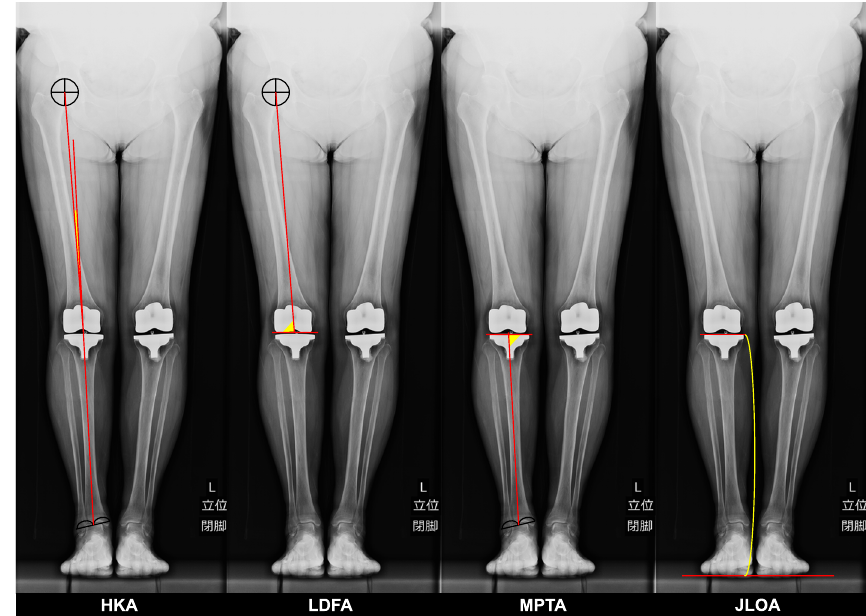
Fig. 2 Measurements on closed-leg standing long leg radiographs. Abbreviations: HKA: hip-knee-ankle angle; JLOA: joint line orientation angle; LDFA: lateral distal femoral angle; MPTA: medial proximal tibial